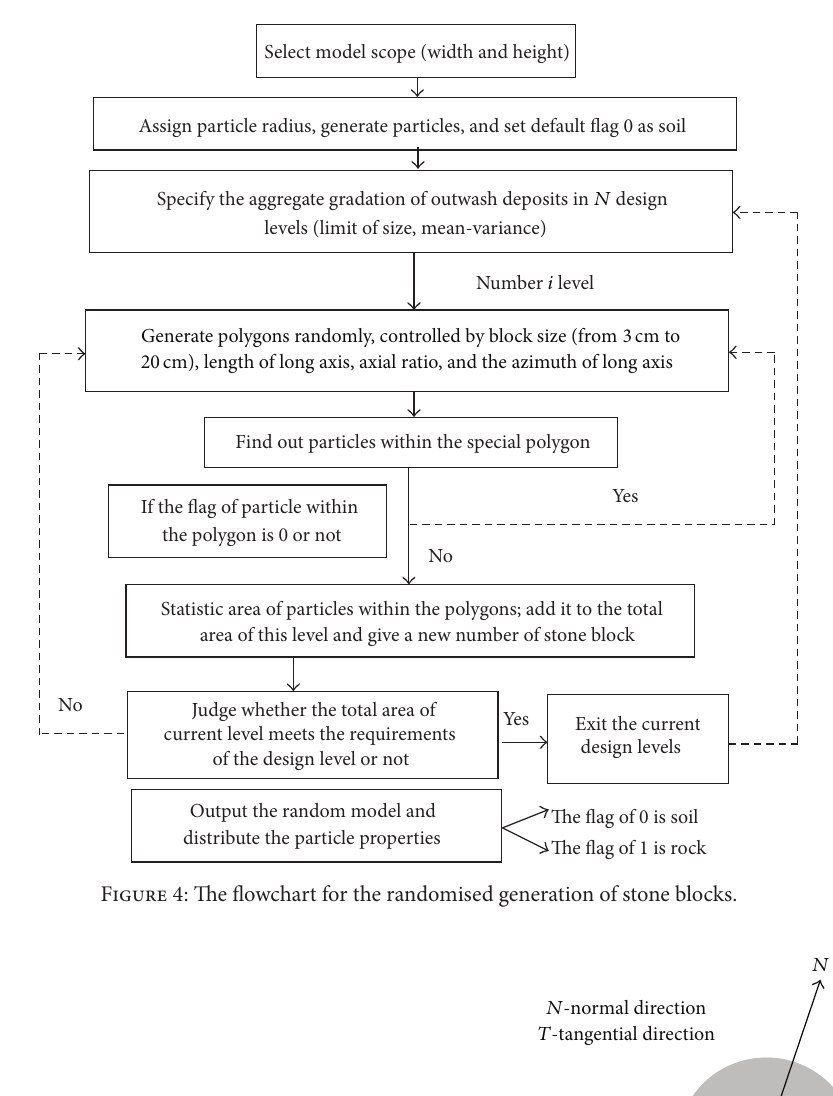
Figure 4: The flowchart for the randomised generation of stone blocks.